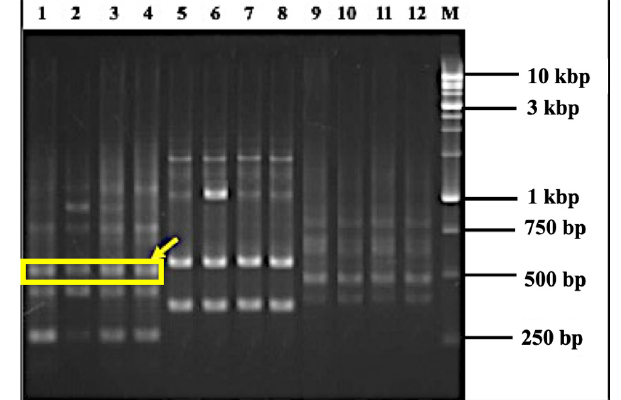
Figure 3. RAPD fingerprints amplified from DNA samples using primers OPU 12 on 1.2% agarose gel. Lanes 1 and 2 are biological samples while lanes 3 and 4 are technical replicates of C. kaliana ; lane 5 is a biological sample while lanes 6 to 8 are technical replicates of C. stenochila ; lane 9 is a biological sample while lanes 10 to 12 are technical replicates of C. tiomanensis . Lane M represents the 1.0 kb DNA ladder (Promega, USA). Fragments indicated by arrows were the specific bands selected and sequenced for SCAR marker primer pair